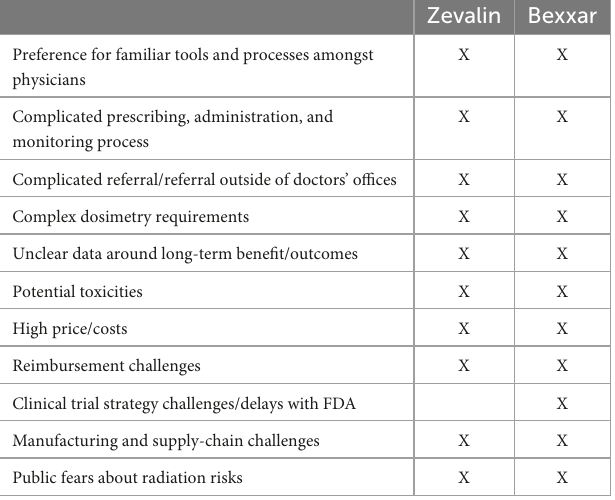
TABLE 1 Reasons cited for the commercial challenges of Zevalin and Bexxar, highlighting market-driven forces that contributed to declining sales and discontinuation of the